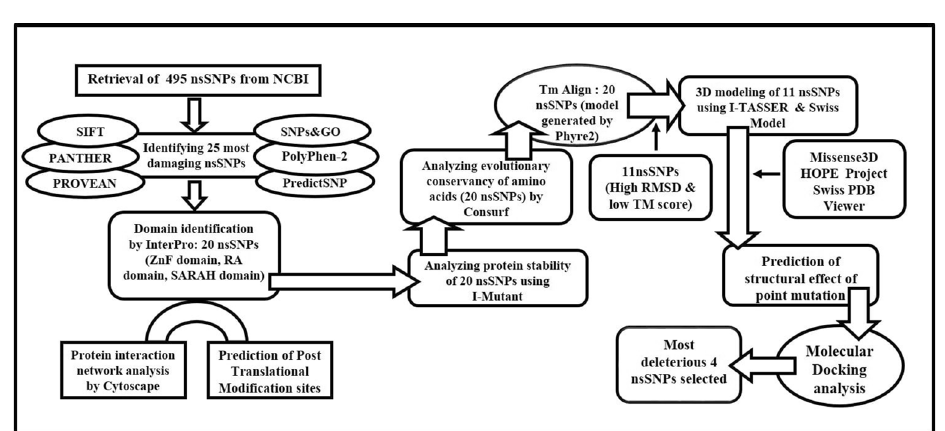
Figure 2. Schematic diagram summarizing the